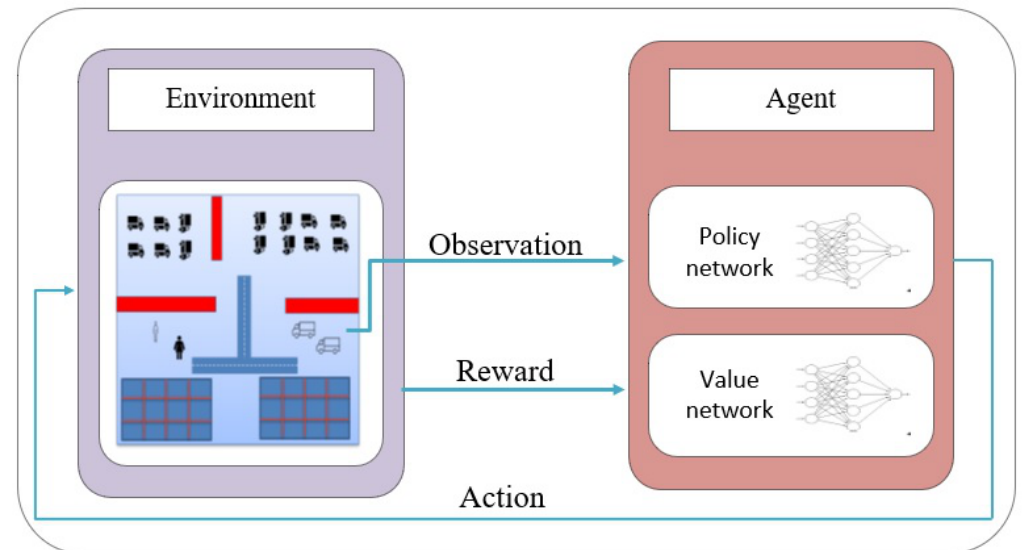
Figure 1. General structure of the navigation system explored in this